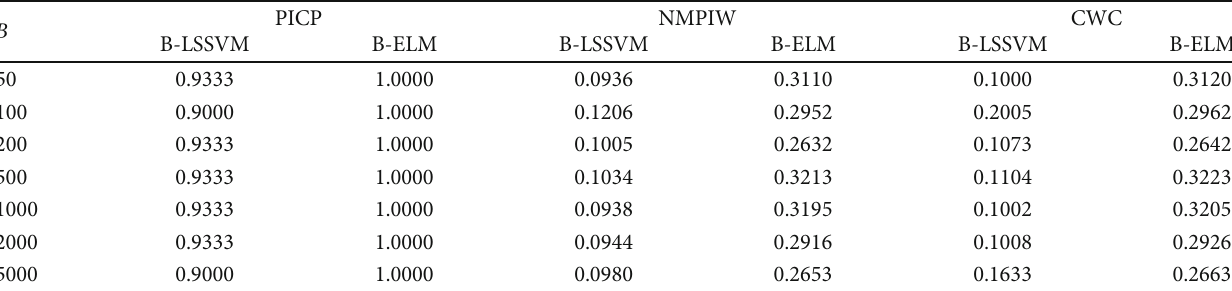
Table 2: PI performance index of